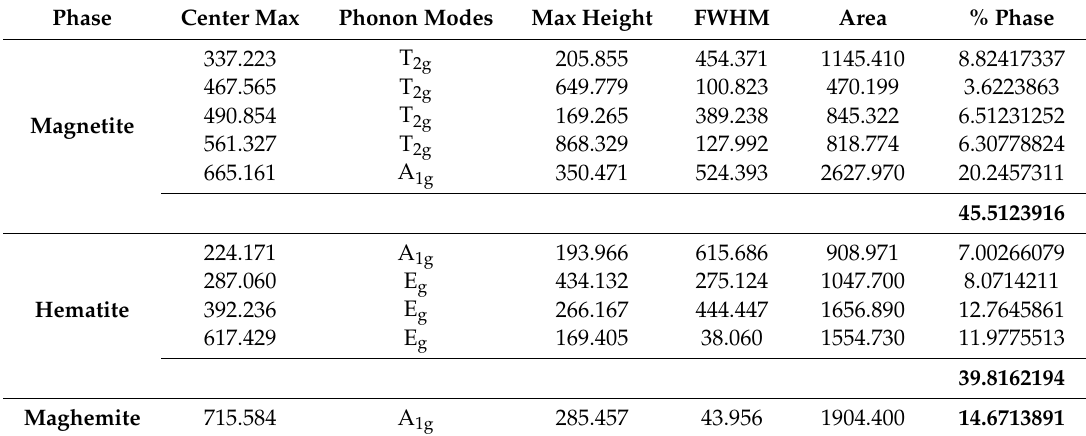
Table 3. Deconvolution of Raman spectra for the quantification of iron oxide phases obtained by green synthesis route.